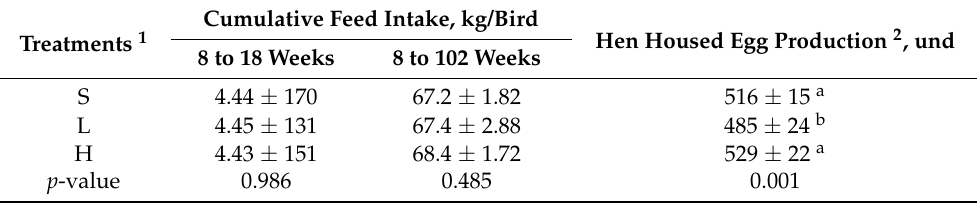
Table 3. Cumulative feed intake and hen-housed egg production ( ± standard deviation) of laying hens from 8 to 102 weeks old in response to age in three dietary balanced protein levels.